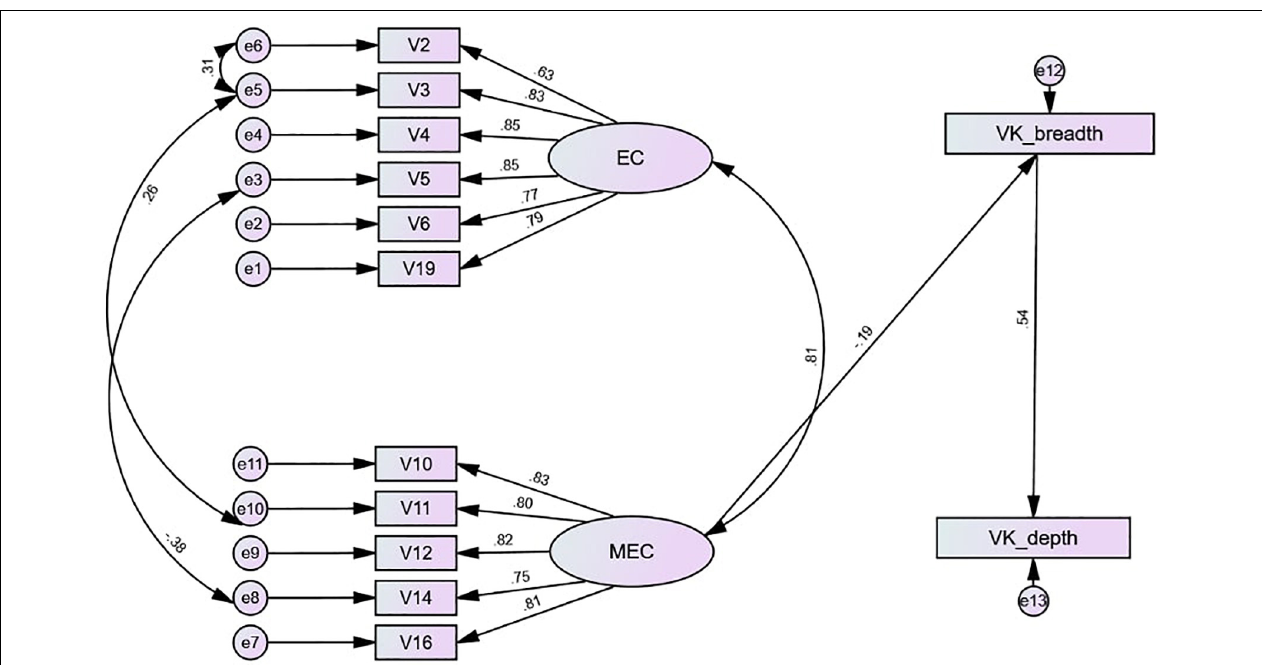
FIGURE 3 | Self-regulation and vocabulary knowledge. EC, emotion control items, MEC, metacognitive control